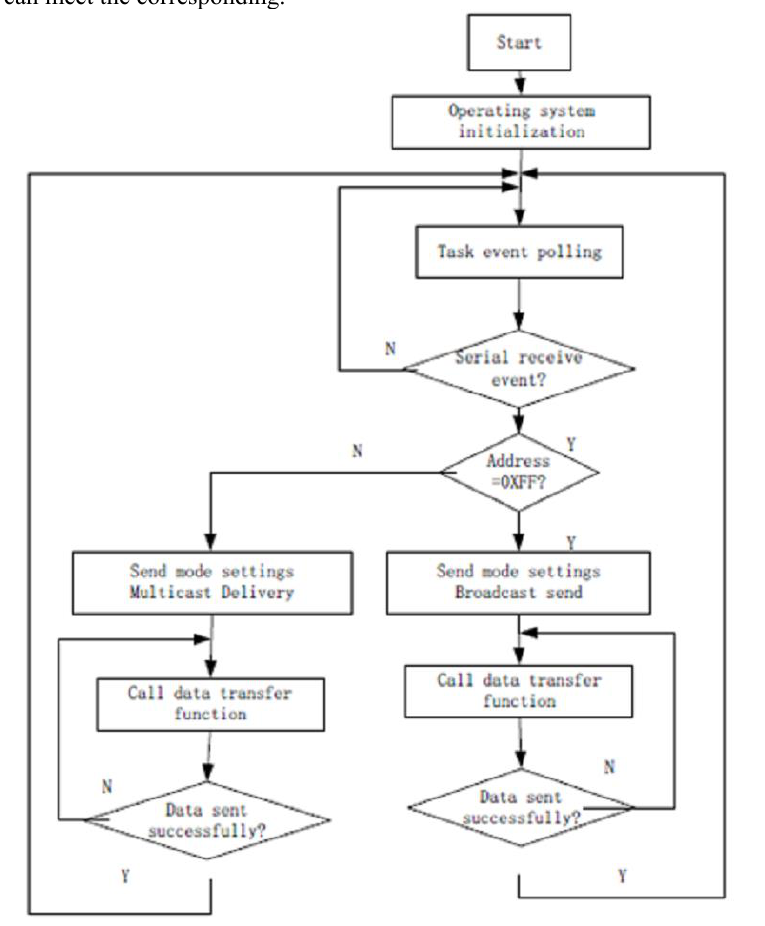
Fig. 2. Controller Structure